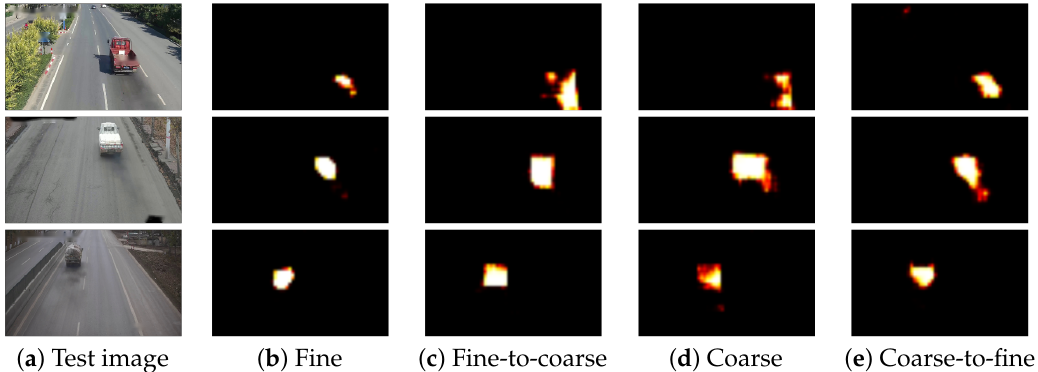
Figure 6. The heat map of the prediction results from the DB-Net, which is trained by different training strategies.